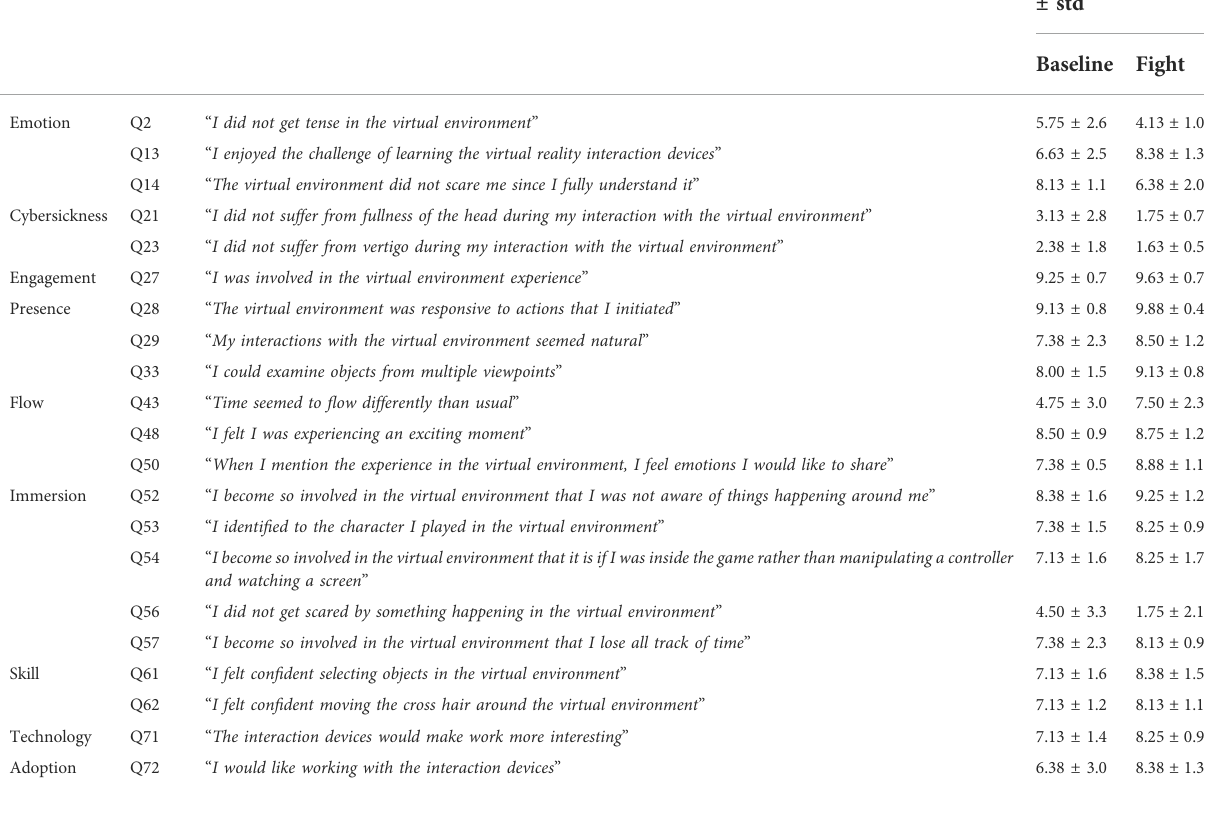
TABLE 1 Summary of the 21 scales that showed signi fi cant differences between baseline and exploration/ fi ght conditions across all subjects. Scales